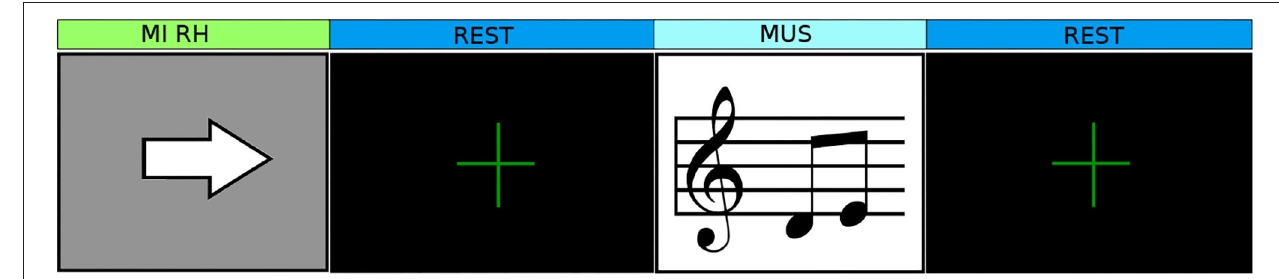
FIGURE 1 | Example of an experimental paradigm applied in the investigation phase. We tested different time intervals of 5 s of tasks and 10 s of rest, 3 s/5 s, 3 s/10 s in order to determine the time interval that elicited prominent brain patterns.